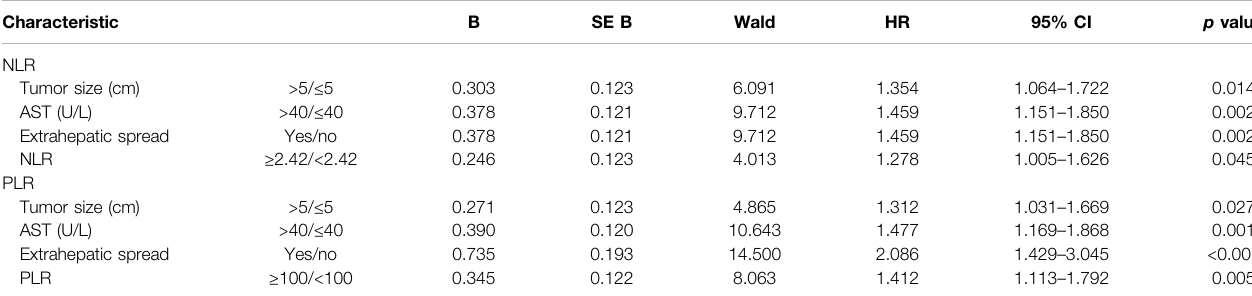
TABLE 5 | Multivariate Cox proportional hazards regression analysis of NLR and PLR with progression-free survival.